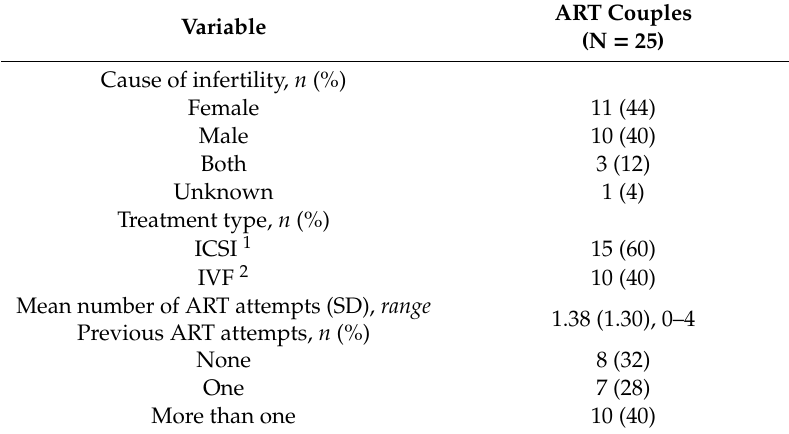
Table 2. Clinical data regarding sub-fertile couples who conceived through ART. ART Couples Variable (N = 25) Cause of infertility, n (%) Female 11 (44) Male 10 (40) Both 3 (12) Unknown 1 (4) Treatment type, n (%) ICSI 1 15 (60) IVF 2 10 (40) Mean number of ART attempts (SD), range Previous ART attempts, n (%)